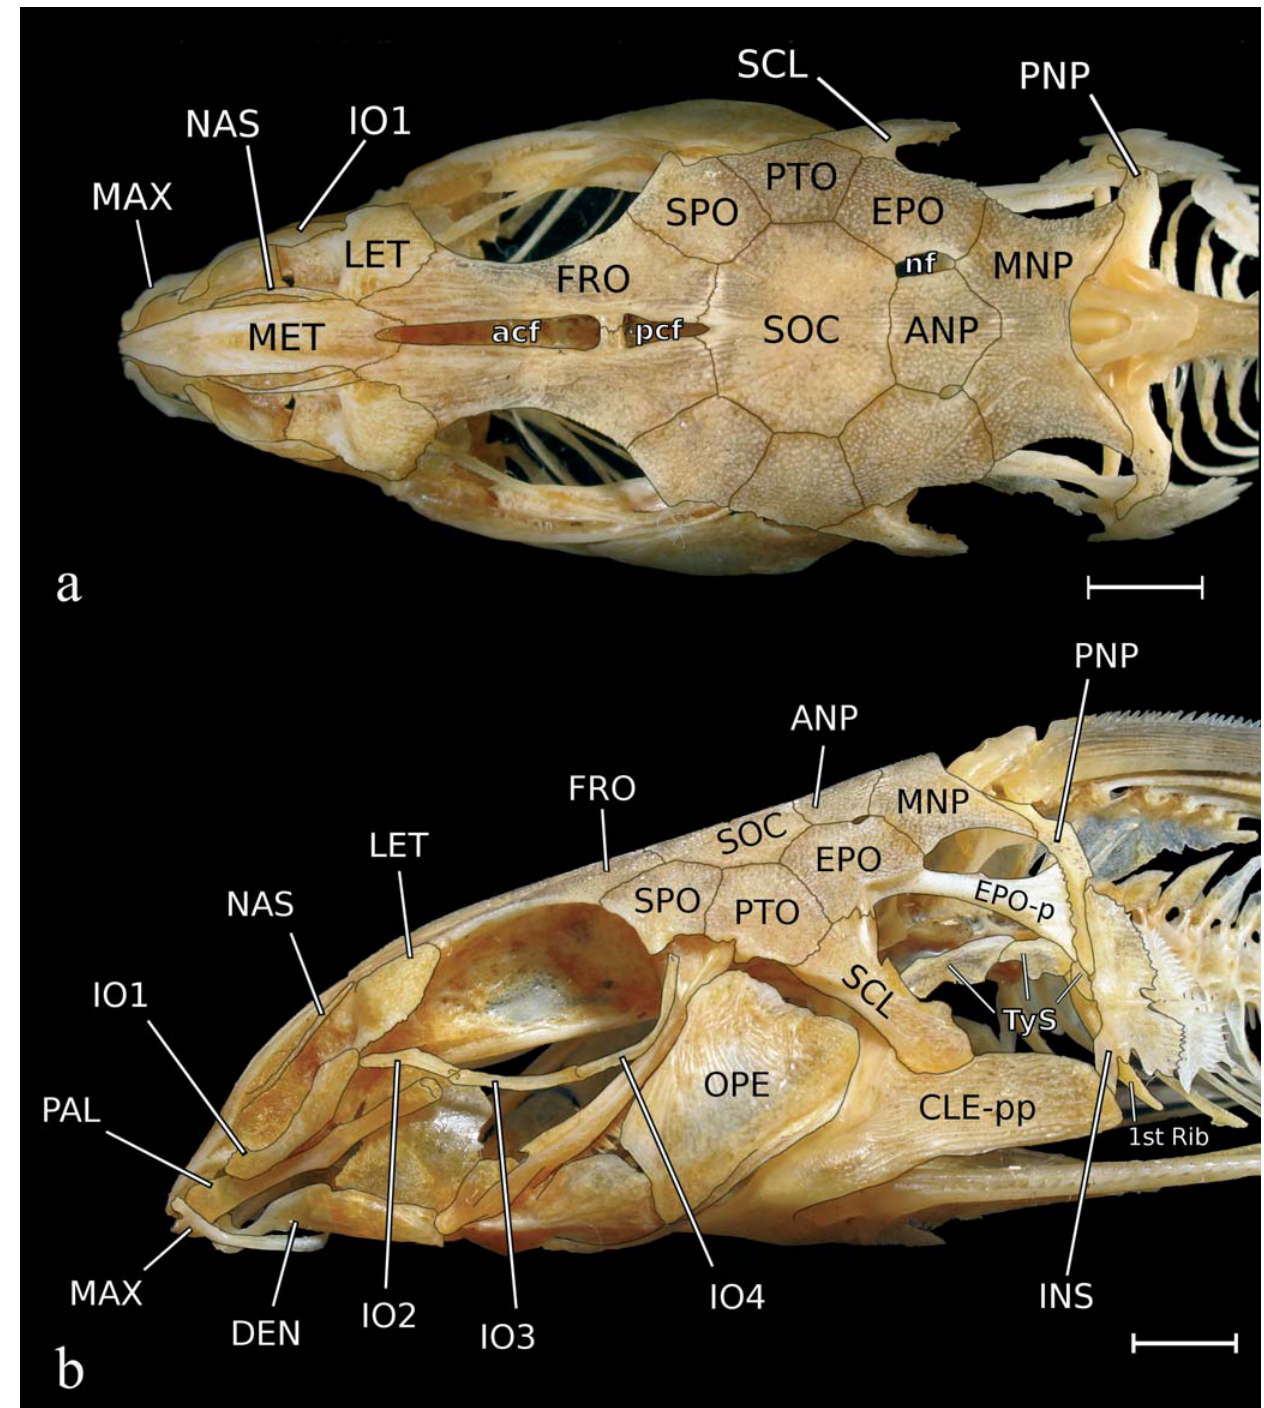
Fig. 7. Head of Leptodoras oyakawai , ANSP 187336, paratype, 120 mm SL, in (a) dorsal and (b) lateral (left side) views. acf anterior cranial fontanel, ANP anterior nuchal plate, CLE-pp postcleithral process, DEN dentary, EPO epioccipital, EPO-p epioccipital posterior process, FRO frontal, INS infranuchal scute, IO1-4 infraorbitals, LET lateral ethmoid, MAX maxilla, MET mesethmoid, MNP middle nuchal plate, NAS nasal, nf nuchal foramina, OPE opercle, pcf posterior cranial fontanel, PNP posterior nuchal plate, PAL autopalatine, PTO pterotic, SOC parieto-supraoccipital, SCL posttemporal-supracleithrum, SPO sphenotic, TyS tympanal scutes. Scale bar 5